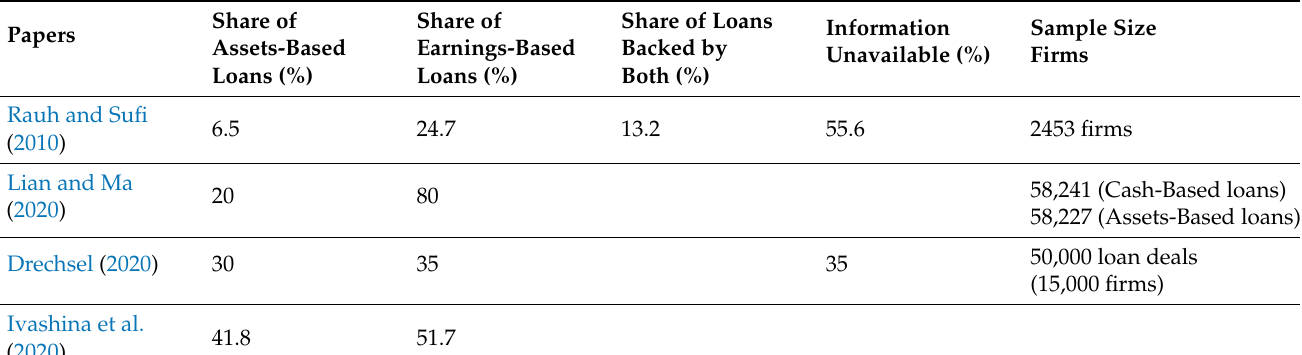
Table 1. Share of Asset Based Lending vs. Earnings-Based